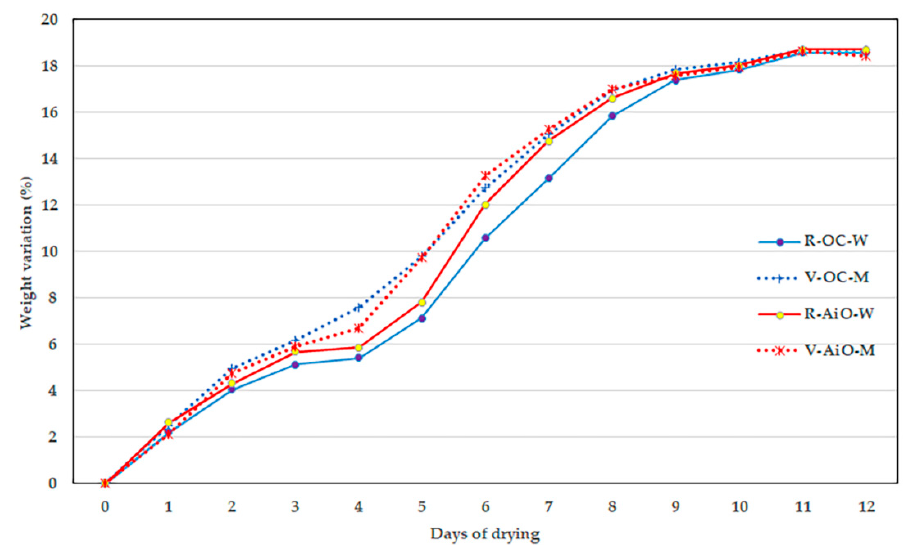
Figure 4. Weight loss caused by brick desiccation.